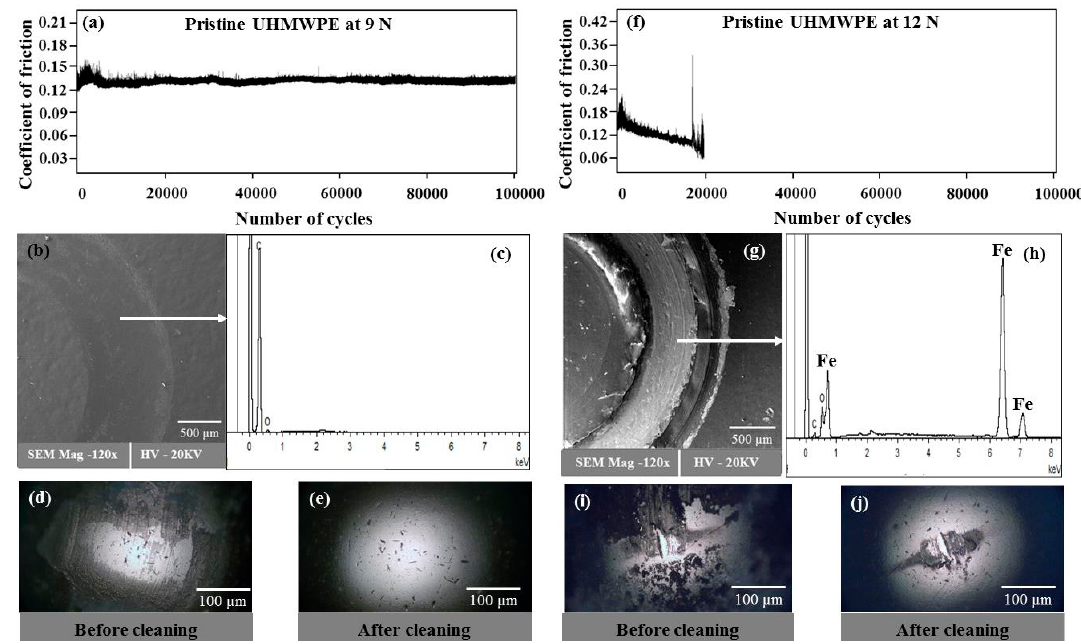
Figure 7. ( a , f ) Typical frictional graphs; ( b , g ) FESEM images of the wear track; ( c , h ) EDS spectrum on the wear track; counterface ball image ( d , i ) before cleaning and ( e , j ) after cleaning after a sliding wear test conducted at normal loads of 9 N and 12 N, respectively, for a pristine ultra-high molecular polyethylene (UHMWPE) coating, at a linear speed of 0.1 m/s for 100,000 cycles.